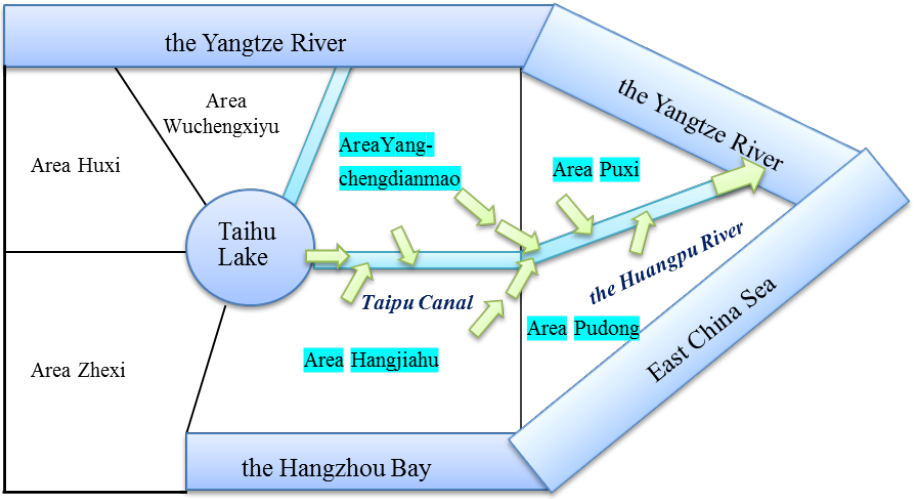
Figure 7. Conceptual drainage system along Lake Taihu, the Taipu Canal, the Huangpu River, and the Yangtze River estuary.